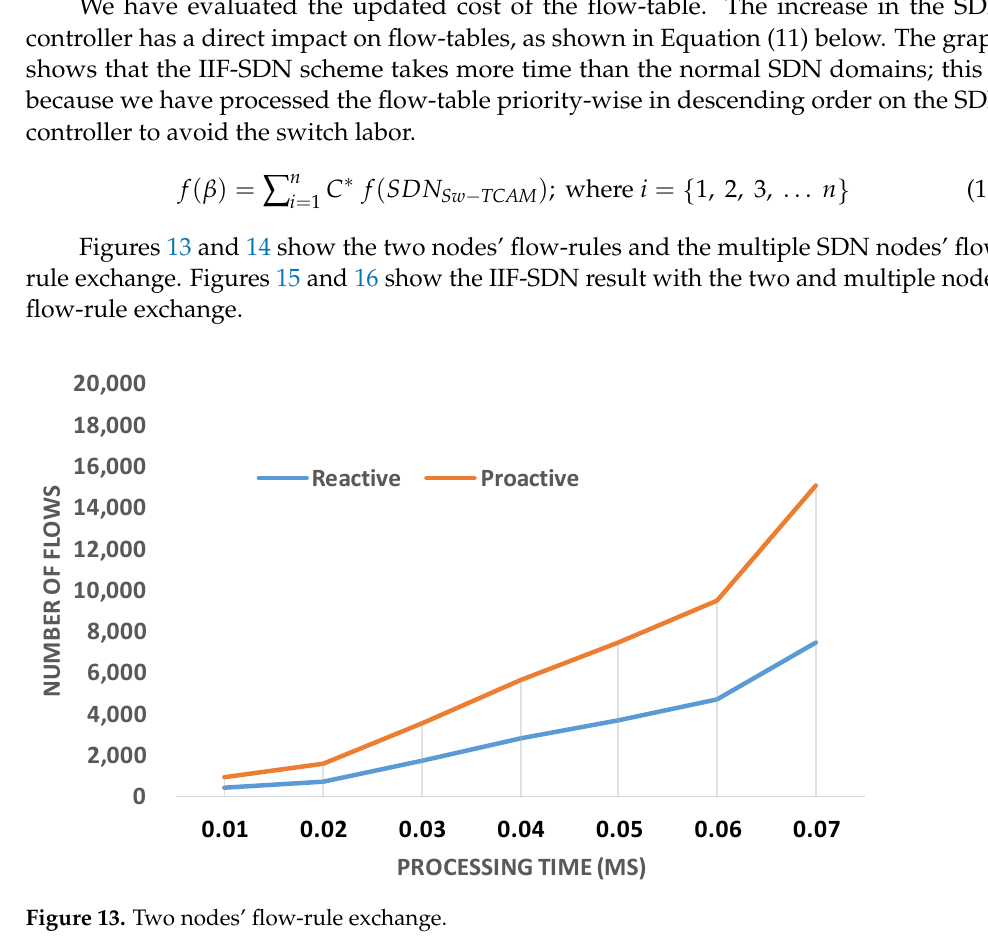
Figure 14. Multiple SDN nodes ’ flow-rule exchange.